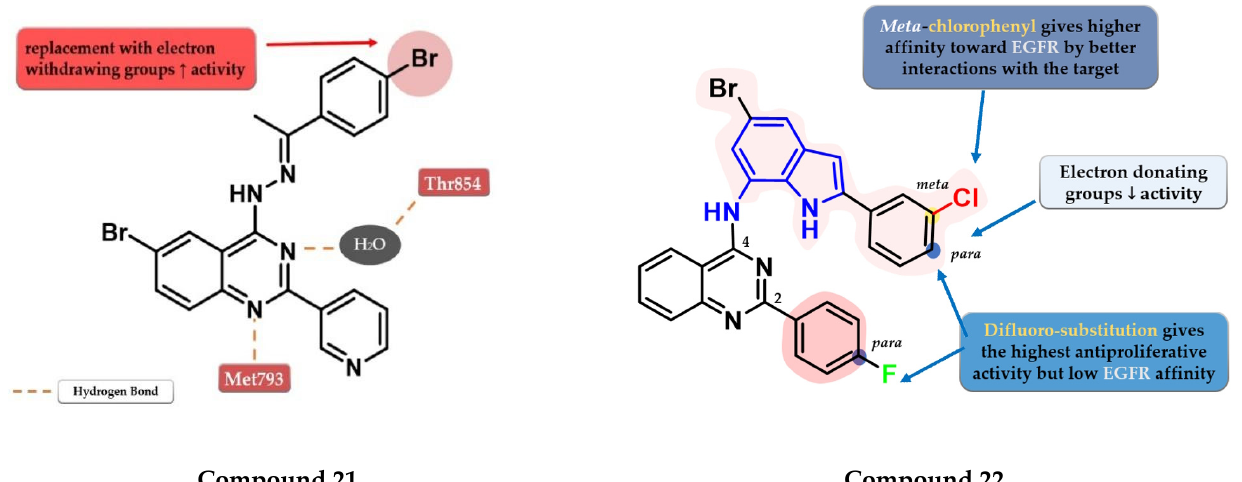
Figure 13. Structure–activity relationship and molecular docking of compound 21 in the human EGFR kinase domain (PDB ID 1XKK) [101], as reported by Ahmed et al. [127]; structure–activity relationship of compound 22 , as reported by Mphahlele et al. [128].